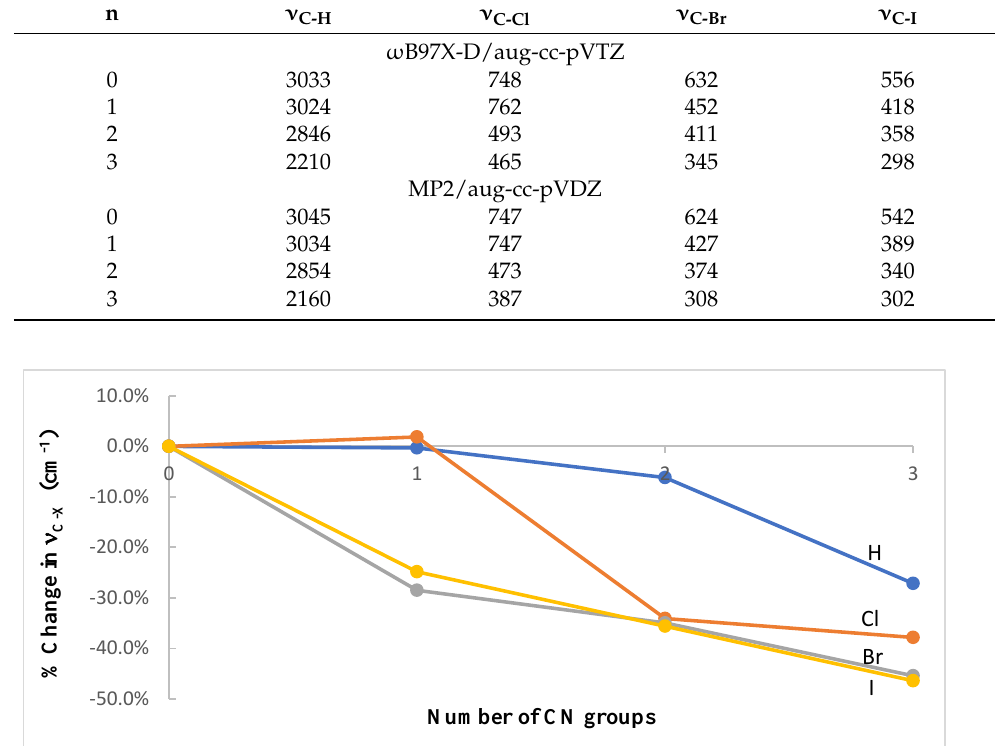
optimized at the ω B97X-D/aug-cc-pVTZ level of